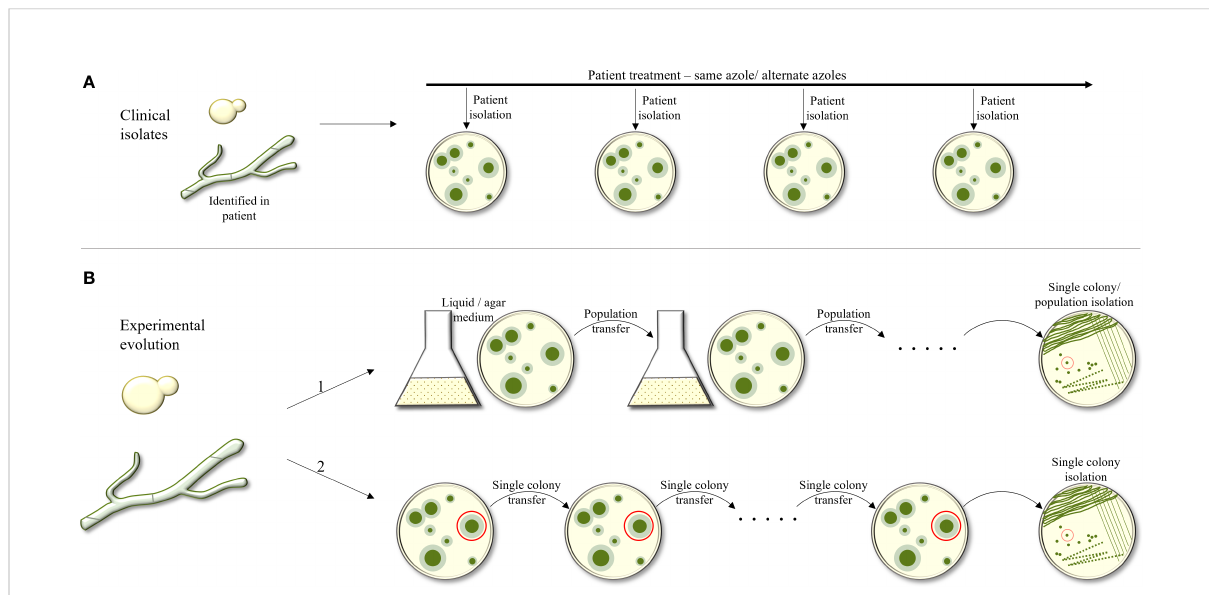
FIGURE 1 Outline of experimental approaches used to study evolution of triazole resistance. (A) Collection of serial fungal isolates from an infected patient over time. Isogenic strains are identi fi ed and compared. (B) Experimental evolution in – vitro . The fungus is passaged under increasing tiazole concentrations, in liquid broth or on agar plates. In B1, a population of the strain under selection is collected and passaged onto the next agar plate or broth tube, containing increasing antifungal concentrations. In B2, during each passage, only one colony or CFU is selected from the agar plate and transferred to the next